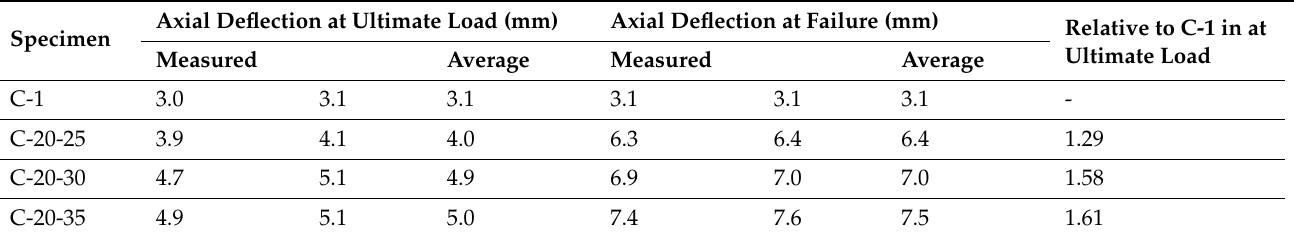
Table 3. Axial deflections of all